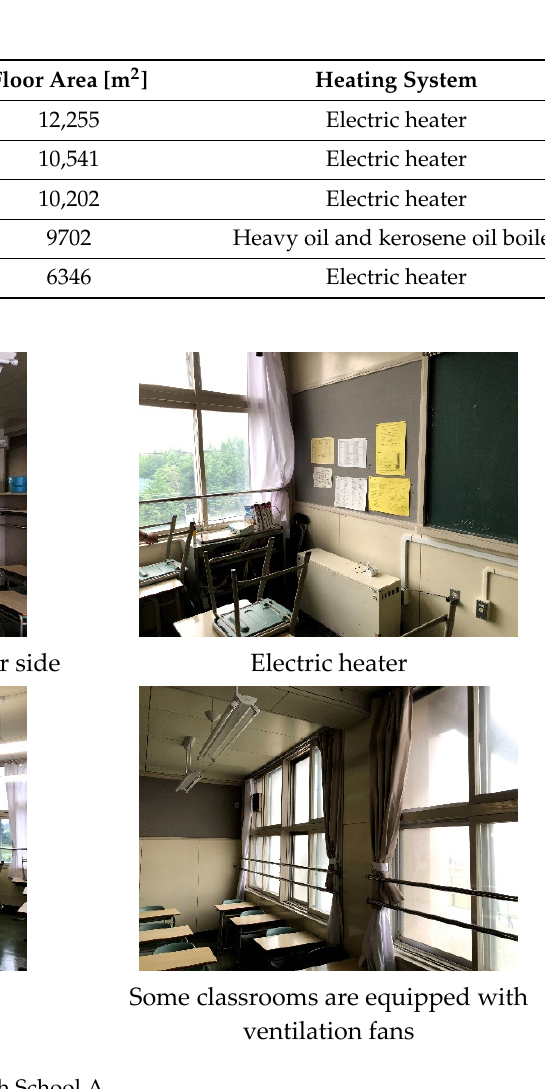
Figure 2. Picture of the classroom in High School